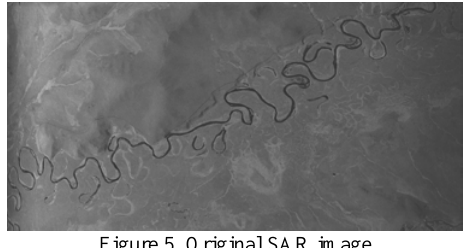
Figure 5. Original SAR image